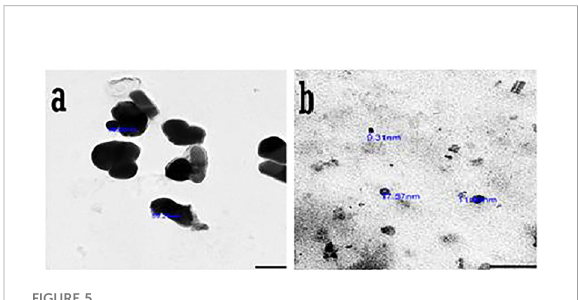
FIGURE 5 Transmission Electron Microscope (TEM) photographs of PoSeNPs (A, B) with magnifying fi eld 100nm and diameter.